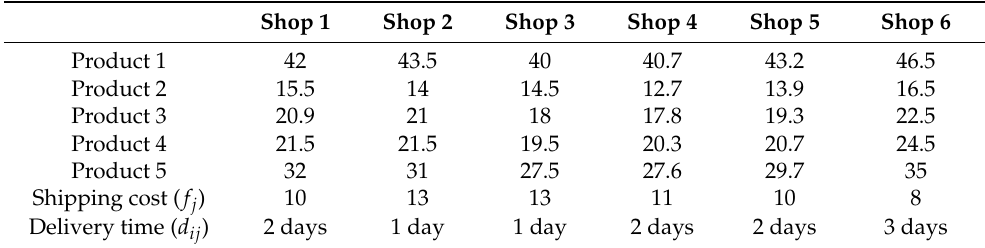
Table 3. Rules for constructing dual problems.